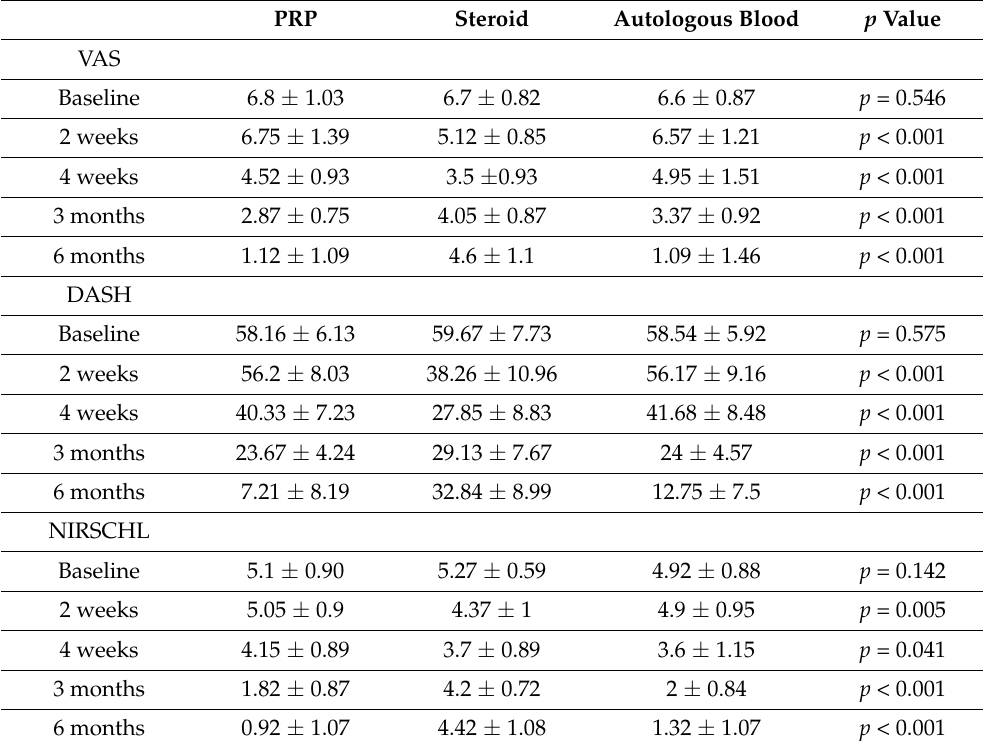
Table 2. VAS, DASH, and Nirschl score changes of patients over time.